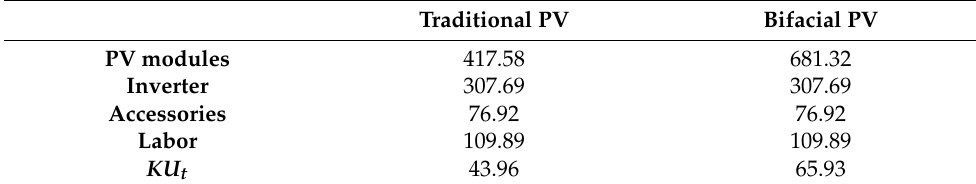
Table 19. Costs of the components of the photovoltaic installation subject to the analysis [EUR].